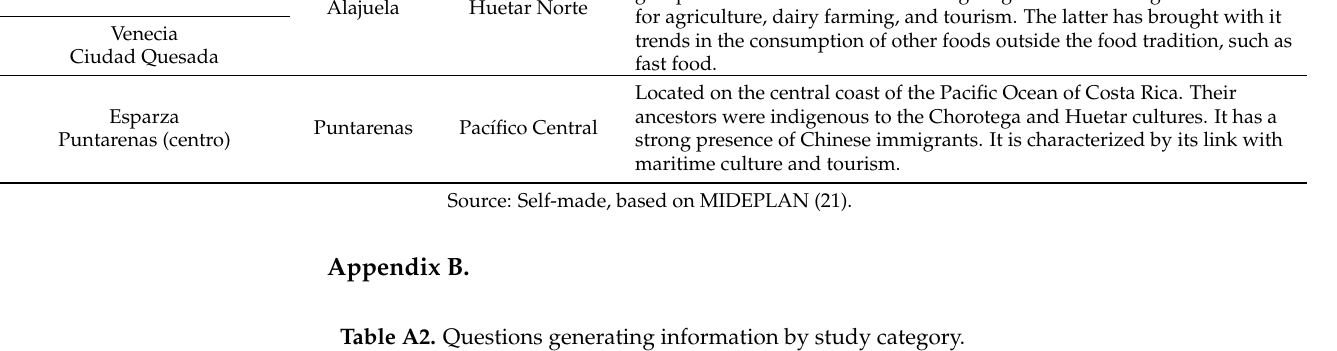
Table A2. Questions generating information by study